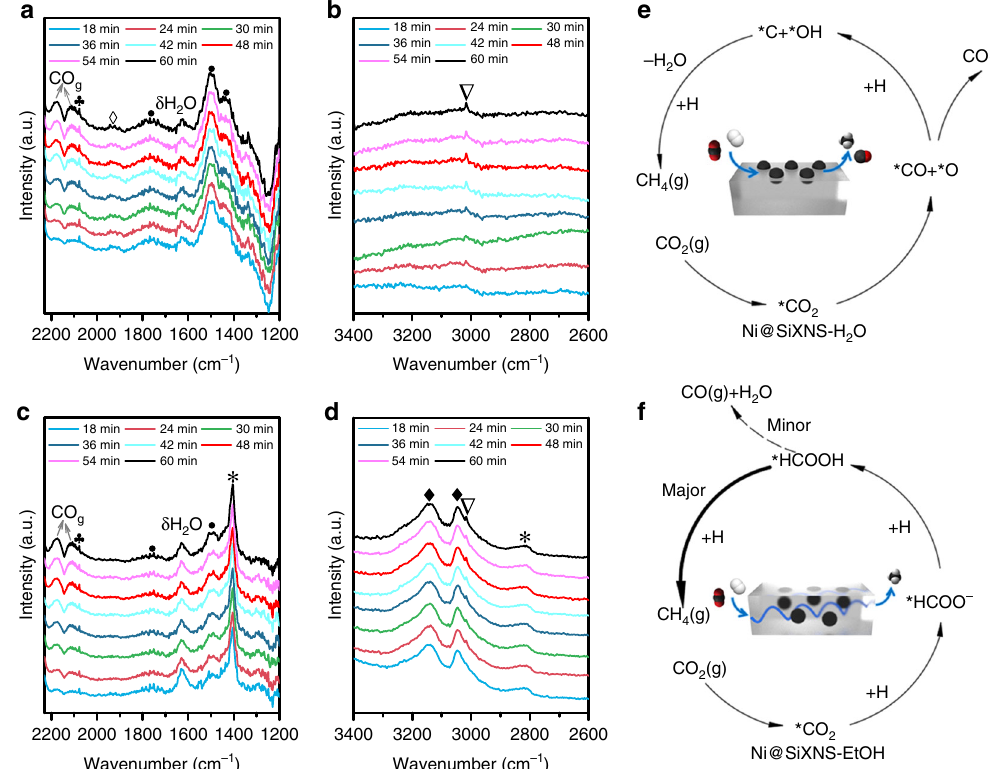
Fig. 6 In-situ DRIFTS experiments and proposed catalytic pathways. a – d In-situ DRIFTS spectra of samples Ni@SiXNS-H 2 O ( a , b ) and Ni@SiXNS-EtOH ( c , d ). e , f The catalytic reaction pathways of Ni@SiXNS-H 2 O- ( e ) and Ni@SiXNS-EtOH- ( f ) catalyzed CO 2 reduction and the key reactions involved that can be detected by DRIFTS. Symbols: ( ♣ ) linear CO; ( ◊ ) bridging CO; ( ● ) carbonate; ( ∇ ) CH 4 ; (*) formate; ( ♦ ) OH